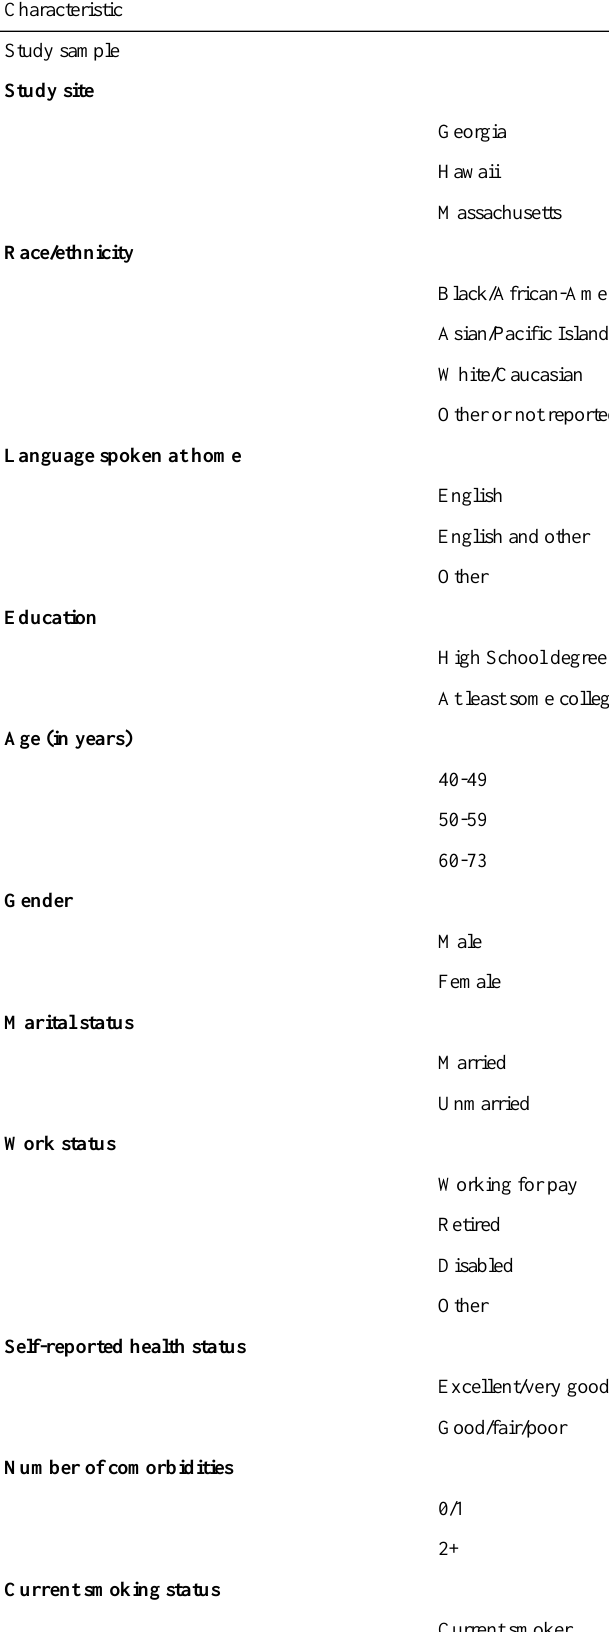
Table 1. Participant characteristics. χ 2 used to derive P values shown for age, gender, race/ethnicity, education, marital status, ever had friends/family diagnosed with CRC, and ever had a colonoscopy. Analysis of variance–ANOVA used to derive P values for health literacy scores, numeracy, and